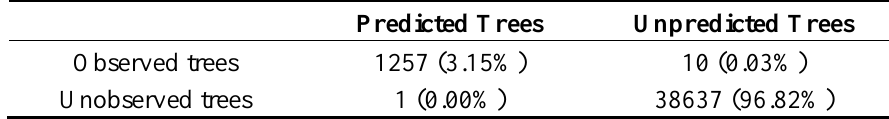
Table 13. Number and percentage of encoder events recorded in each situation during the light curtain validation